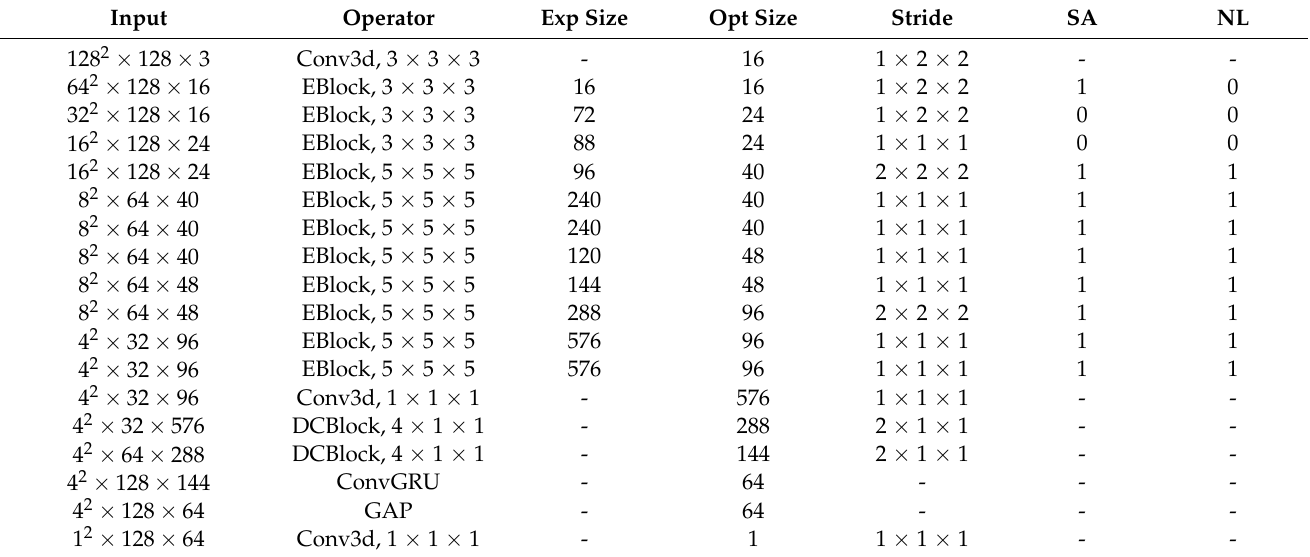
Table 1. The details of the ESA-rPPGNet network structure. Input is the input dimension of each layer H × W × T × C , Operator is the convolution operation in each layer and the corresponding convolution kernel size, and Exp size is the channel of DWC. Opt size is the final output channel number of the Block, Stride is the step size of the DWC, SA indicates whether to use the 3D-SA module, where 1 indicates yes, 0 indicates no, and NL indicates the nonlinear layer type: 0 means ReLU6, 1 means h −